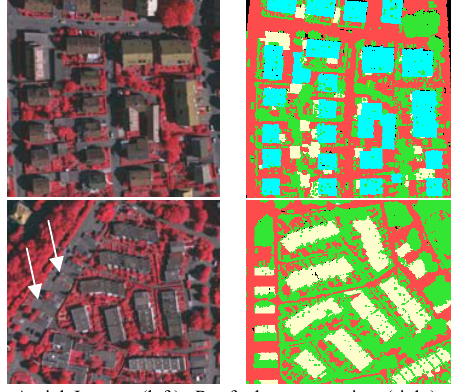
Figure 1: Aerial Images (left), Roof plane extraction (right): cyan – roofs, detected by azimuth constrains, white – flat and other oblique roofs, green – other objects (vegetation and non segmented points), red – terrain. Some vegetation patches, which follow our roof extraction